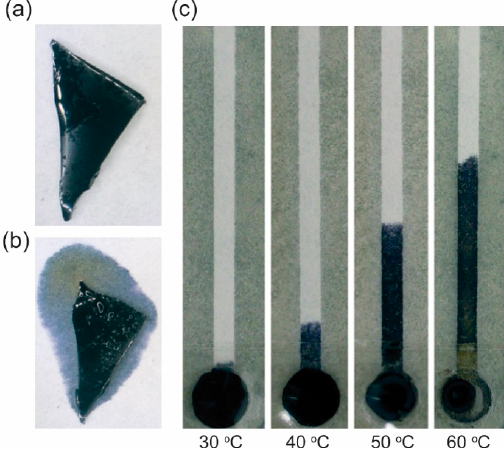
Figure 13. Changing the surface wettability of a paper channel by treating it with UV irradiation to control the flow of fluid in the channel. ( a ) Surface contact angle of a water droplet as a function of time on a paper surface treated with UV irradiation for 0, 5, 10, and 20 min. ( b ) Flow distance of the fluid versus time traveled in paper channels with various geometries due to changes in the wettability of the channel’s surface. ( c ) Sequential fluid delivery in the p-MF device. Adapted with permission from the authors of [91]. Copyright 2016 Springer-Verlag Berlin Heidelberg.